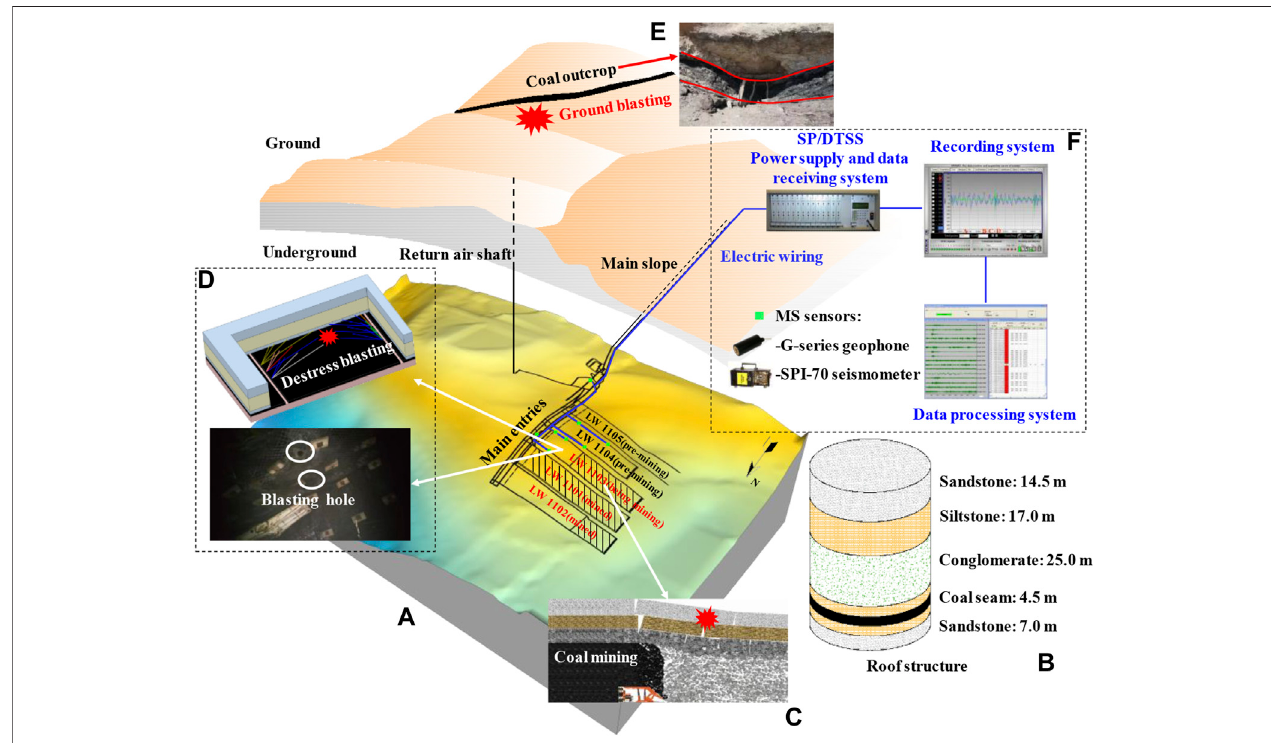
FIGURE 1 | Related information of 3-3# coal seam in the Yutian coal mine. (A) 3 – 3# coal mine fl oor and layout of longwall panel; (B) roof structure; (C) coal mining and roof breakage; (D) destress blasting in the roof; (E) ground blasting in coal outcrop; and (F) microseismic monitoring system.